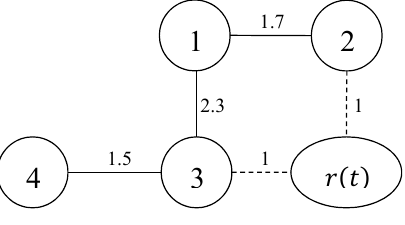
Figure 3. Undirected graph of multi-agent system.